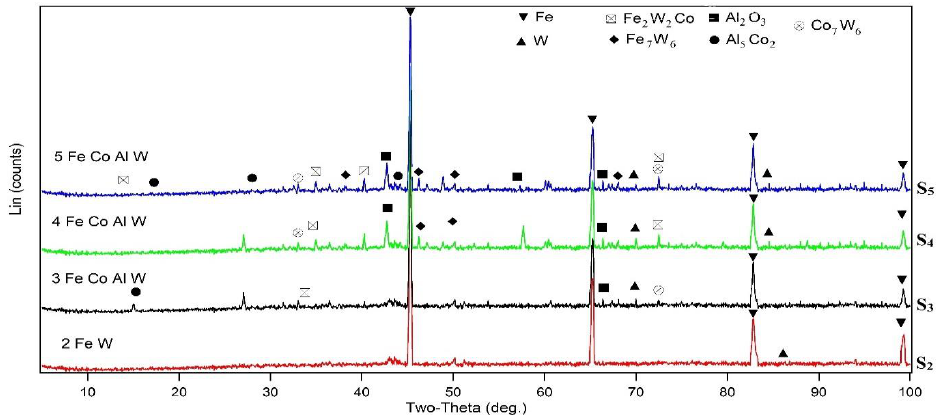
Figure 2. XRD pattern of S 2 , S 3 , S 4 and S 5